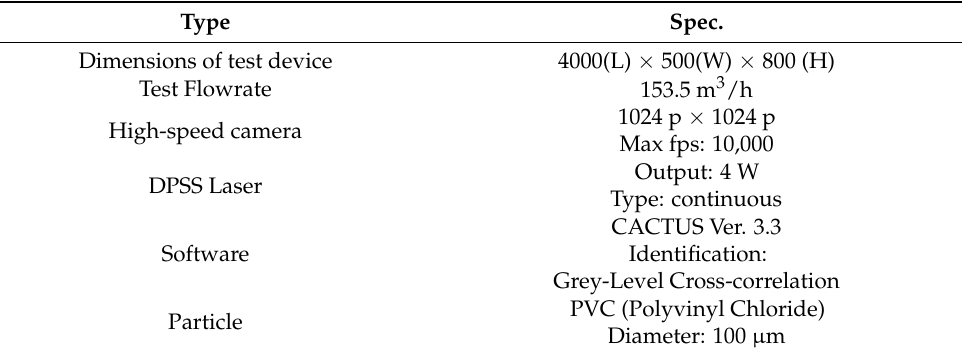
Figure 3. PIV measurement set up. Table 1. Model test specifications for